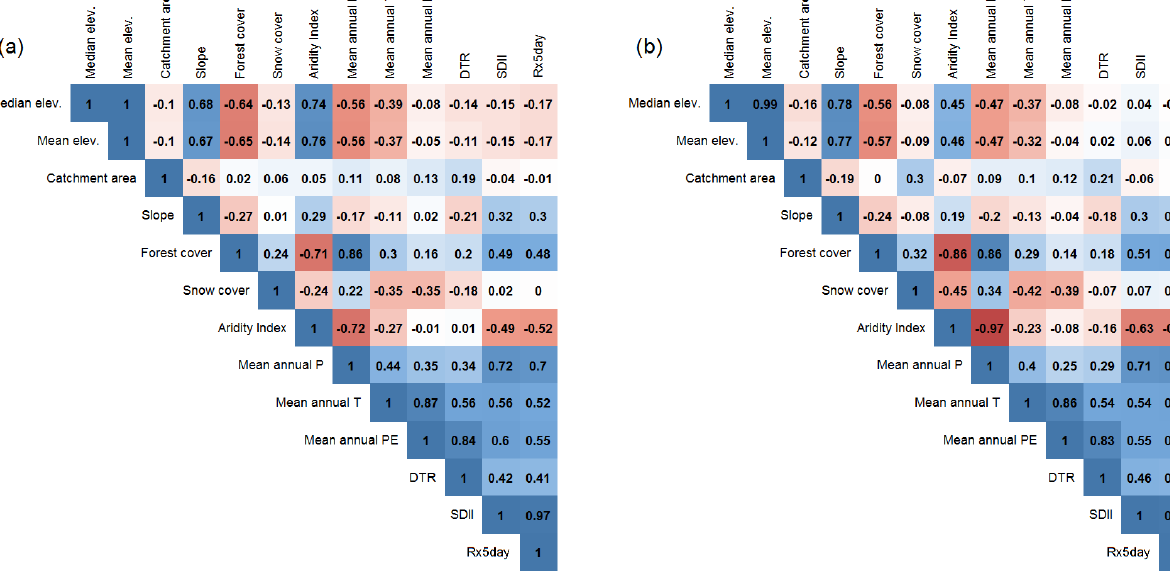
Figure B1. Correlation matrices of the catchment characteristics described in Table 4 using CR2MET as the P product for (a) the Pearson correlation, to evaluate linear correlation, and (b) the Spearman correlation, to evaluate the monotonic correlation.